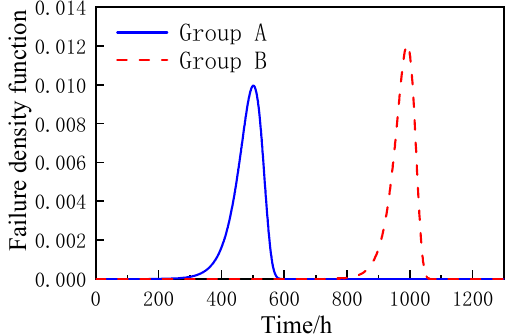
Figure 8. The probability density function of MOCRC.